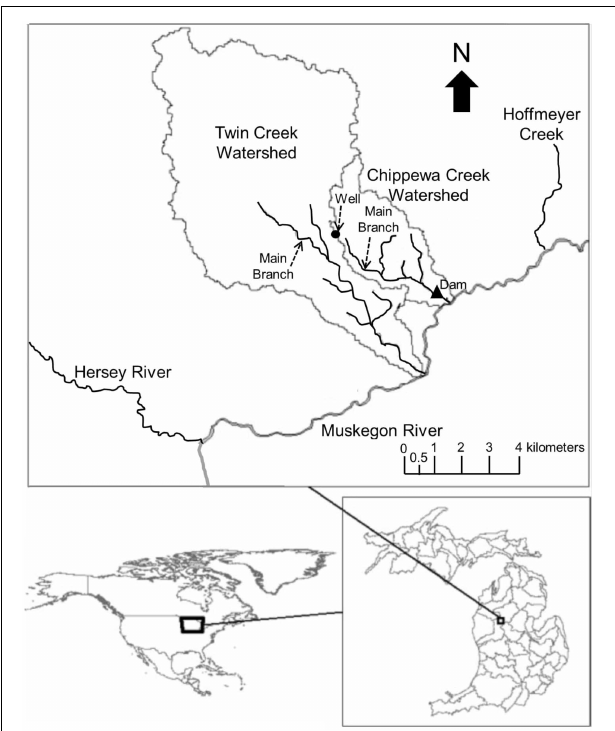
FIGURE 2 | Diagram illustrating metacoupling:social-ecological interactions within a particular or local fishery (intracoupling) as well as between adjacent fisheries (pericoupling) and between distant, non-adjacent fisheries (telecoupling). Different coupling types are illustrated using rivers from the study area (see Figure 1 ). White and black arrows depict flows, defined as movements of water, information, fish, people, and money within and between fisheries. See Table 1 for details on metacoupling systems, flows, agents, causes, and